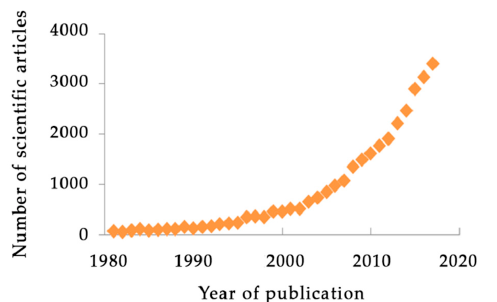
Figure 1. Temporal evolution of published scientific articles on smart farming technologies (SFTs) on a yearly basis (for the period 1981–2017) identified through a Scopus query (as of 18 July 2018).